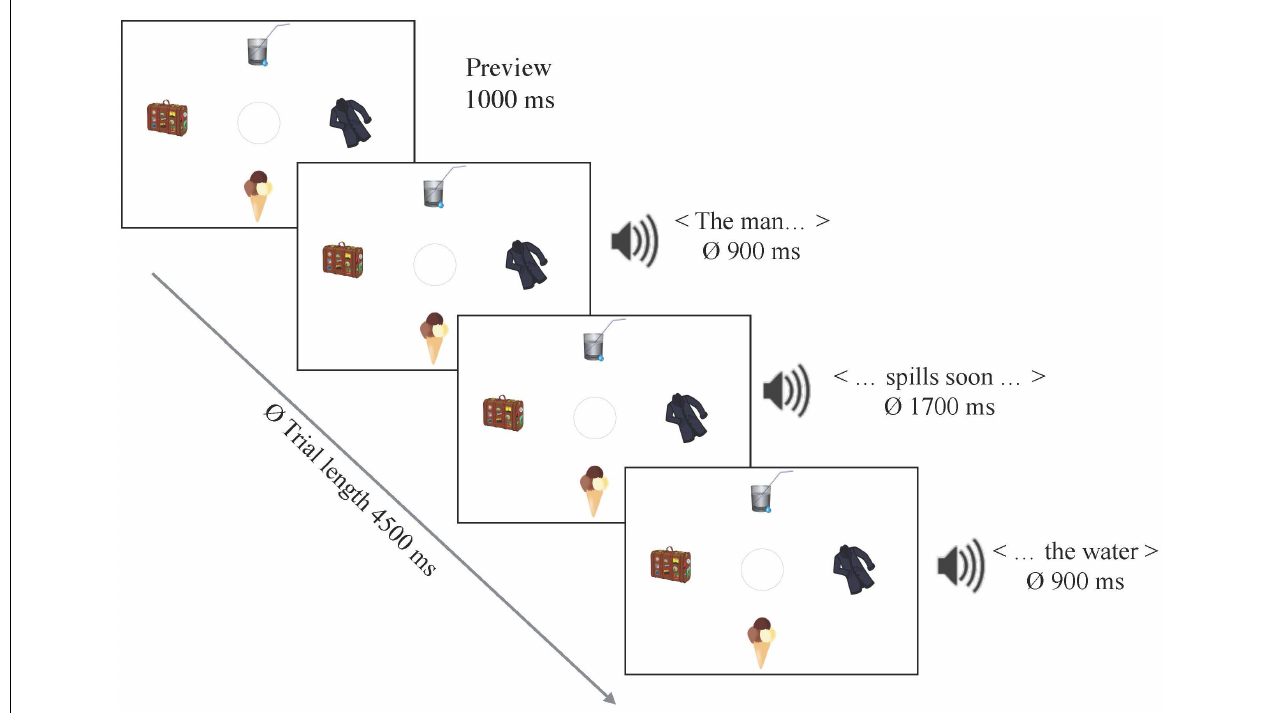
FIGURE 2 | A trial time line and stimulus example for Experiment